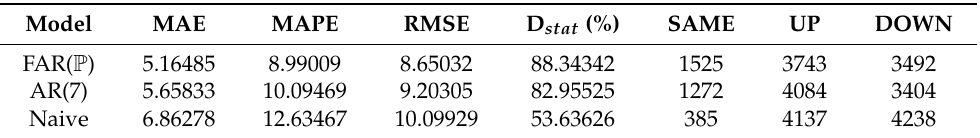
Table 1. IPEX electricity prices: out-of-sample forecasting errors MAE, MAPE, and RMSE for FAR( P ), AR(7), naïve models, and the directional statistics D stat with number of forecasting directions (same, up, down).